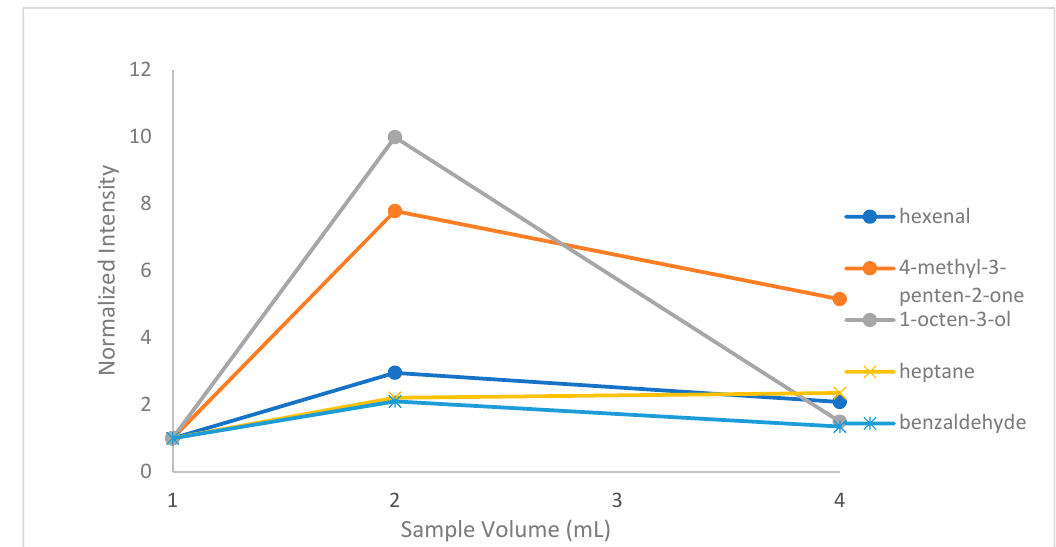
Figure 5. Effect of sample volume on hexanal, 4-methyl-3-penten-2-one, heptane, benzaldehyde and 1-octen-3-ol.